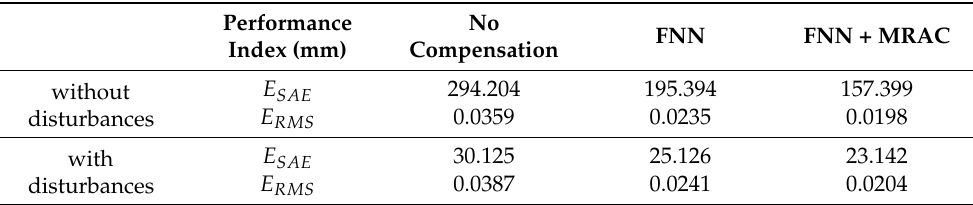
Figure 14. ( a ) The synchronous error under low-frequency commands with disturbances. ( b ) the synchronous error under high-frequency commands with disturbances. Table 2. Synchronous performance under low-frequency commands.